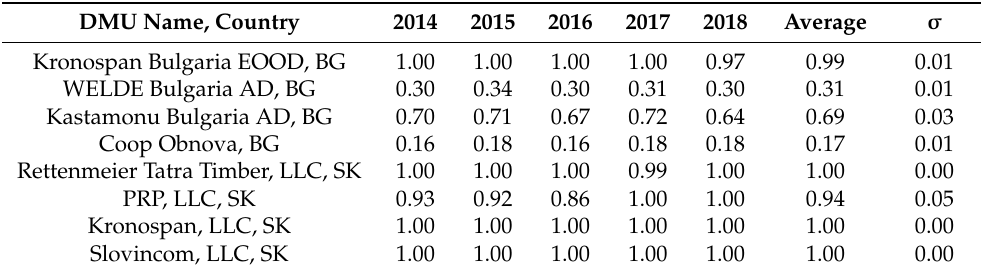
Table 4. CCR scores for DEA with labour and other cost inputs. DMU Name,